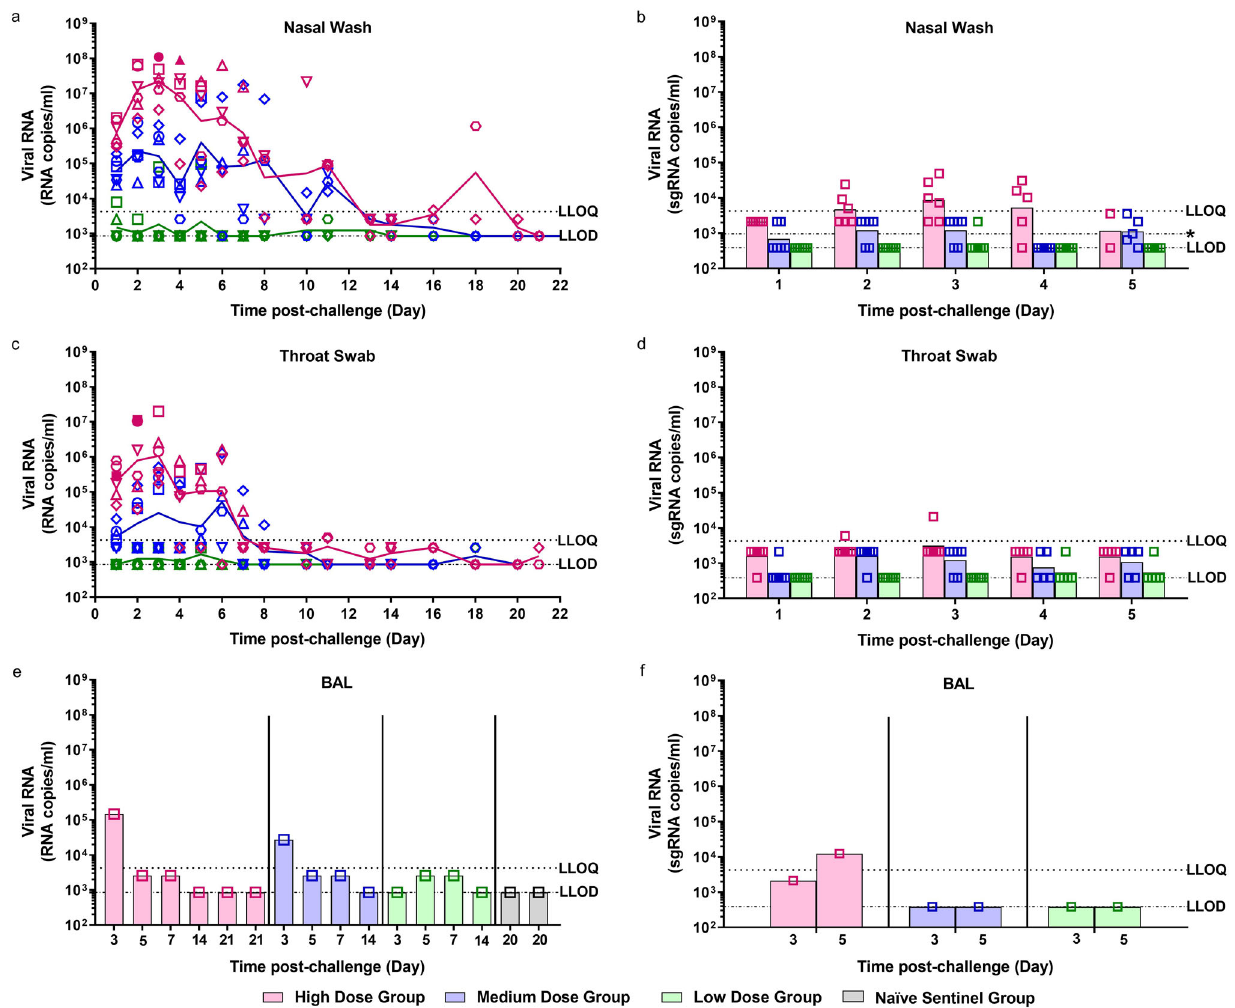
Fig. 1 Viral RNA Shedding. Nasal washes and swabs were collected at days 1 to 8, 10, 11, 13, 14, 16, 18 and 20 pc for all virus challenged groups. Viral genomic RNA was quanti fi ed by RT-qPCR at all timepoints. No viral RNA was detected in any samples taken from the naïve sentinel ferrets. Samples that were found to be positive by plaque assay are represented by a solid shape. ( a ) Nasal washes ( c ) Throat swabs ( e ) Bronchoalveolar lavage (BAL) collected at necropsy (numbers indicate day post-challenge the ferret was euthanised). Symbols show values for individual animals, lines represented the calculated group geometric means. The presence of viral subgenomic RNA was assessed in ( b ) nasal washes, ( d ) throat swabs and ( f ) BAL from 1 to 5 dpc. Bars show geometric mean for each group and symbols show values for each individual animal. n = 6 ferrets per group with numbers decreasing by 1 at 3, 5, 7 and 14 dpc. The dashed horizontal lines show the lower limit of quanti fi cation (LLOQ) and the lower limit of detection (LLOD). [*LLOD range for nasal washes represents 2 undetected samples at 5 dpc had <5 µ l template